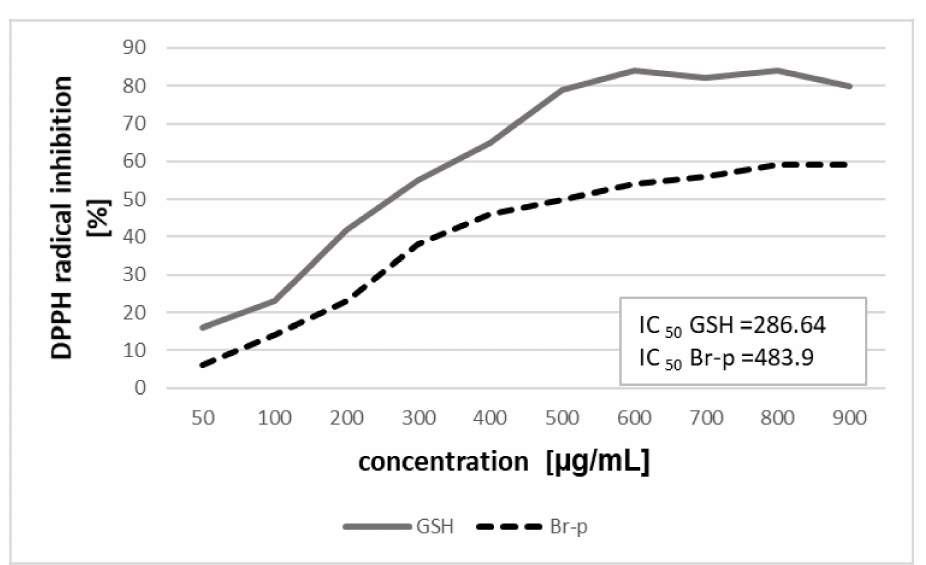
Figure 3. The 2,2-diphenyl-1-picrylhydrazyl radical scavenging activity of Br-p compared with standard